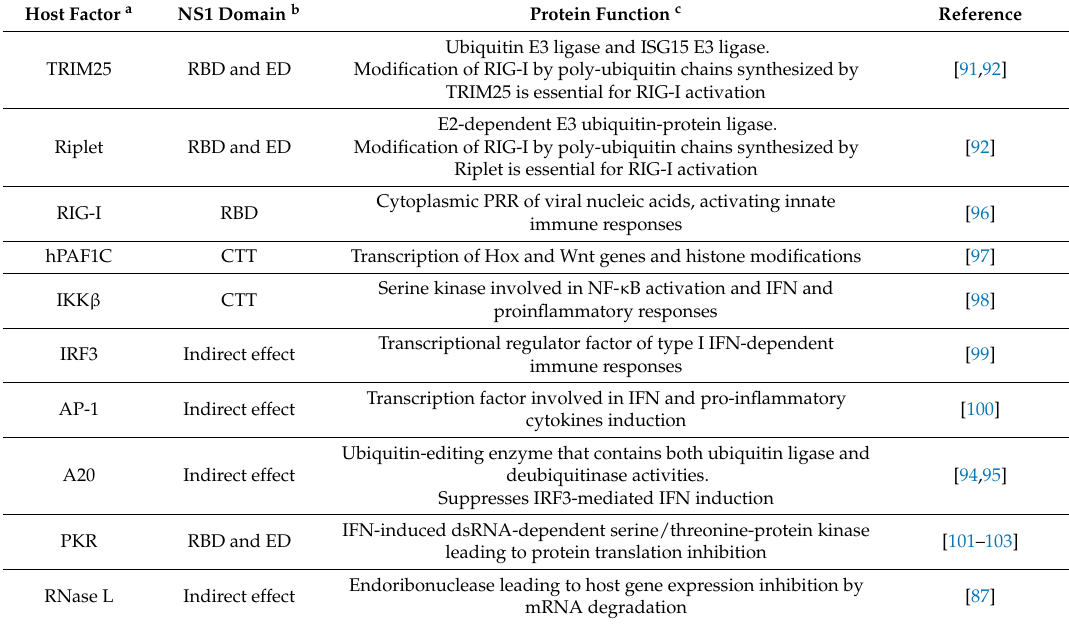
Table 1. Interactions of the IAV NS1 protein with cellular proteins that are involved in innate immune